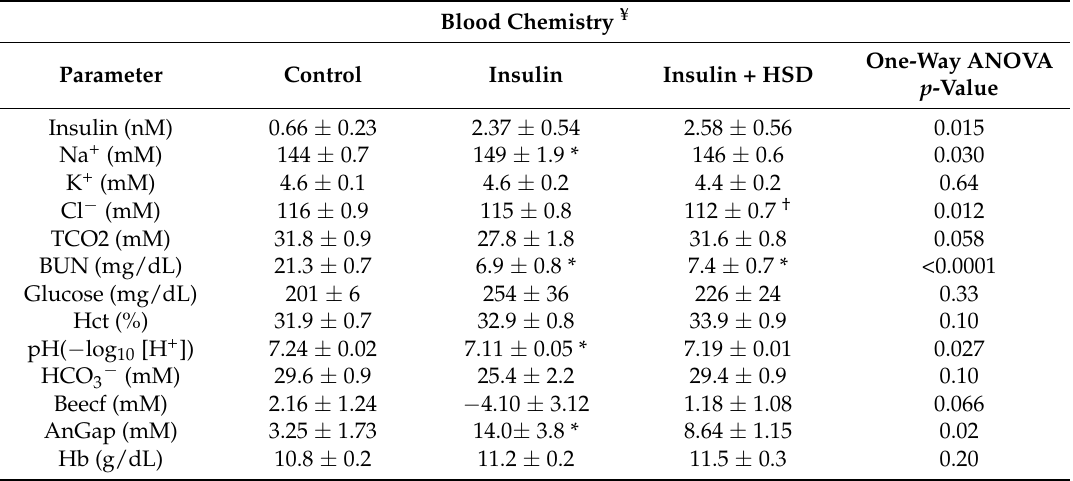
Table 1. Levels of blood/plasma components in control, insulin-infused and insulin-infused plus high-sodium diet (HSD) mice.